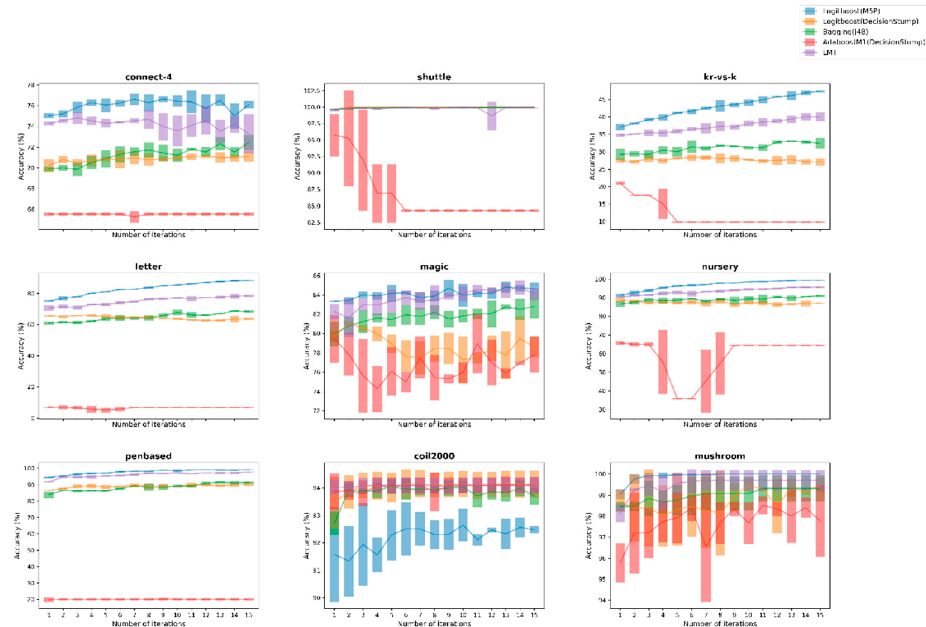
Figure 2. Comparison of the proposed Logitboost(M5P) against 4 ensemble learners over the 9 larger datasets between both binary and multi-class ones for UncS(Ent) with R = 5%.